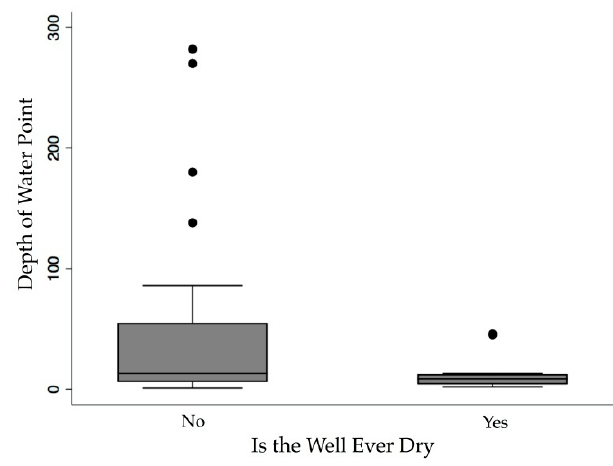
Figure 5. Well depth and drying up of water point.